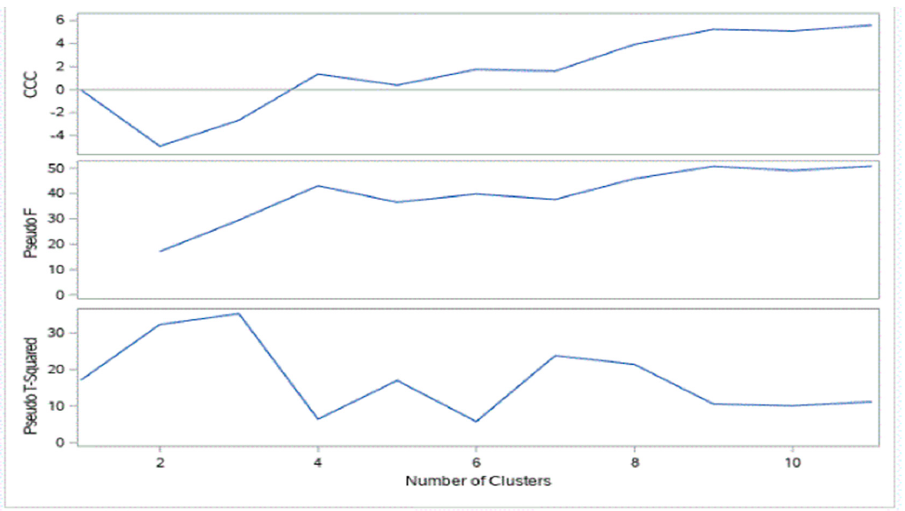
Figure 4. Criteria for Selecting number of Clusters.